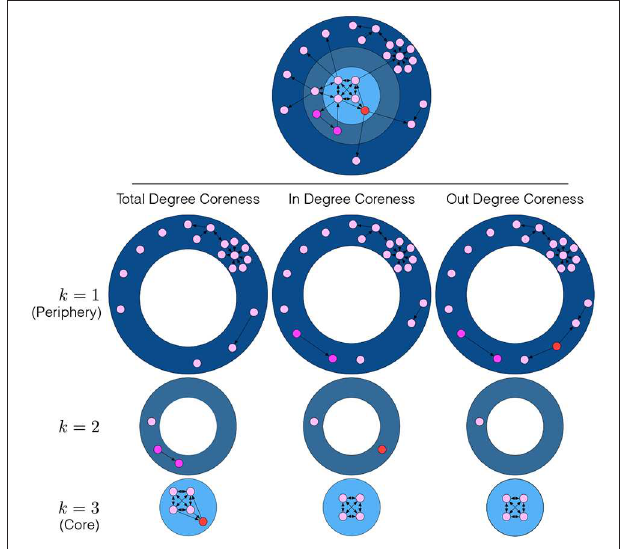
FIGURE 1 | k -core decomposition of a network with 10